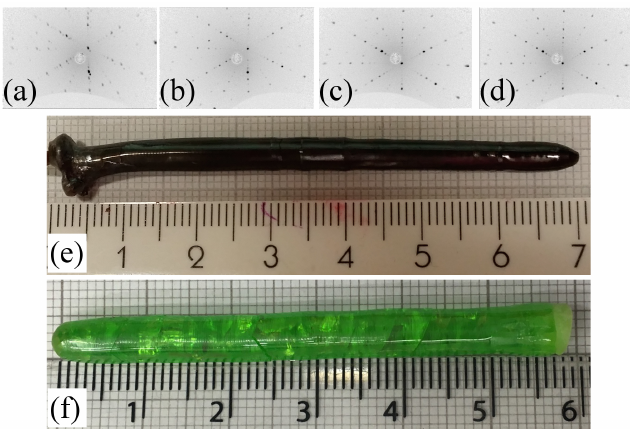
Figure 7. ( a – d ) Laue photographs of one of the facets of a Pr 2 Zr 2 O 7 crystal, taken along the crystal length at „ 15 mm intervals, between the beginning (left) and the end (right) of the boule shown in ( e ). The corresponding Laue patterns taken on the facet at 180 degrees are mirror images of these patterns. ( e ) Boule of Pr 2 Zr 2 O 7 prepared by the floating zone method in air at a growth rate of 12.5 mm/h. ( f ) Boule of Pr 2 Zr 2 O 7 prepared by the floating zone method in argon, at 1 bar pressure and using a growth rate of 12.5 mm/h.